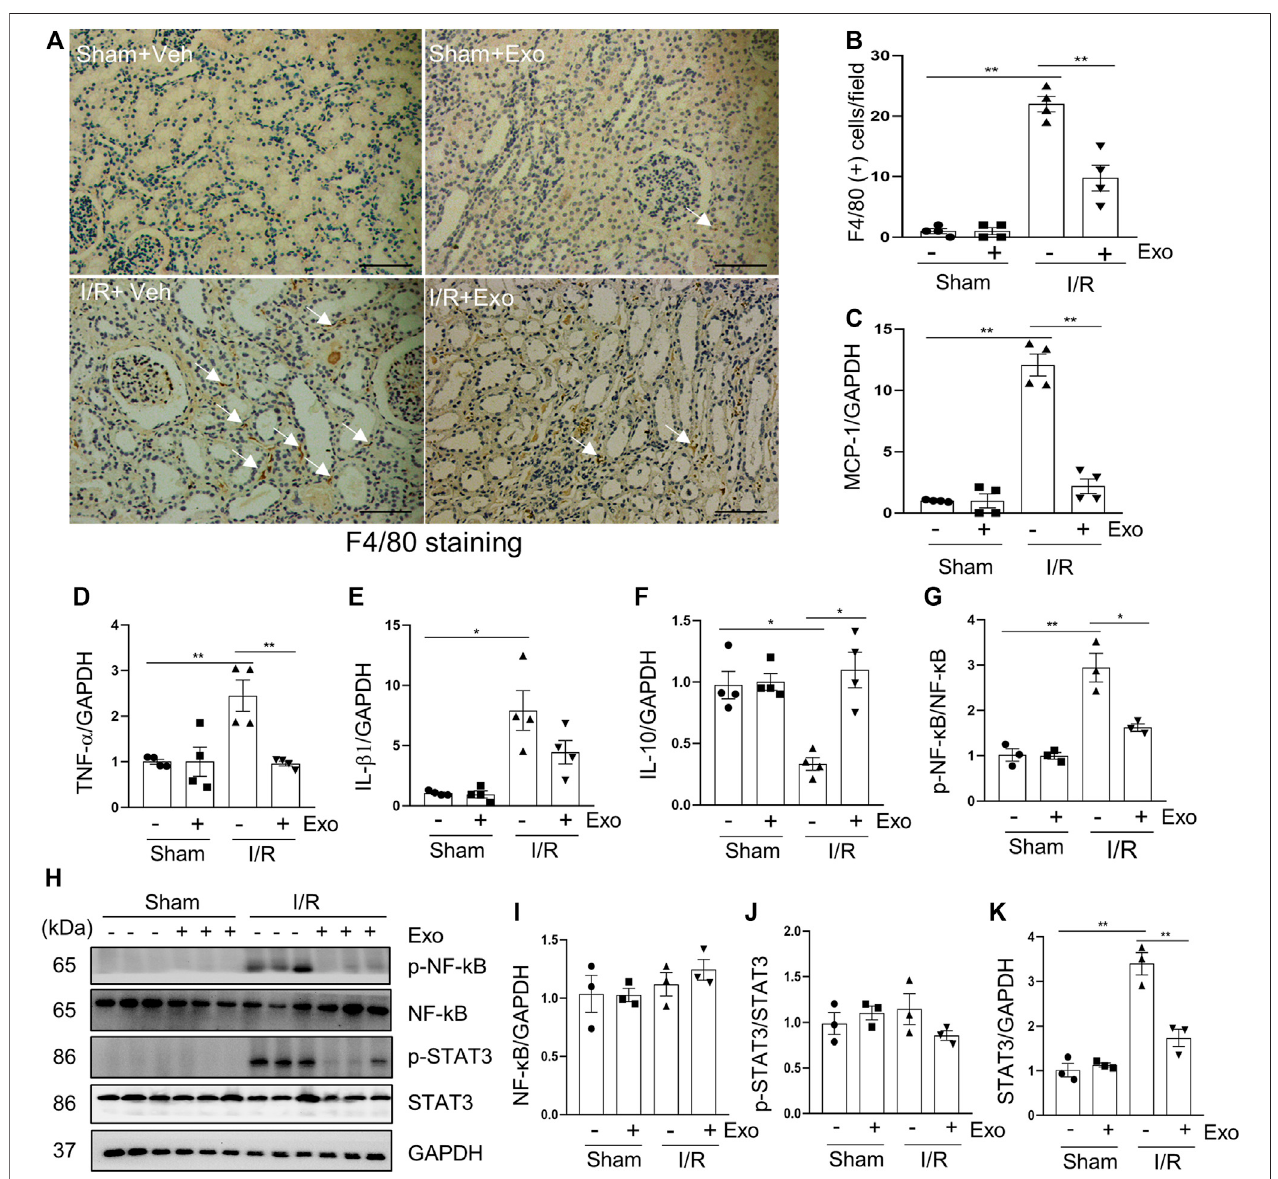
FIGURE 7 | MSCs-derived exosomes inhibited production of pro-in fl ammatory factors. (A) Photomicrographs illustrating immunohistochemical staining of macrophagebiomarkerF4/80Scalebar=100 µm.ArrowspointtoF4/80-positivemacrophages. (B) Quanti fi cationandgraphofthenumberofF4/80positivecellsfrom immunohistochemicalstaining.RT-qPCRwasappliedtodetect theexpressionlevelofthein fl ammatoryfactorMCP-1 (C) ,TNF- α (D) ,IL-1 β (E) and IL10 (F) . (H) Porcine kidneytissuelysates fromfour groups weresubject toimmunoblot analysiswithspeci fi cantibodies against phospho-NF- κ b,NF- κ B, phospho-STAT3and STAT3. Expression levels of NF- κ B (I) and STAT3 (K) were quanti fi ed by densitometry analysis and then normalized with GAPDH. The phosphorylation levels of NF- κ B (G) and STAT3 (J) were calculated quantitatively by densitometry. Data are means ± sem.* p < 0.05; ** p < 0.01 versus sham controls.